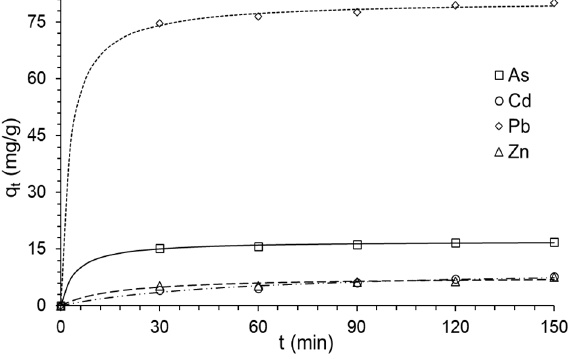
Figure 4. Second-order kinetics modeling.